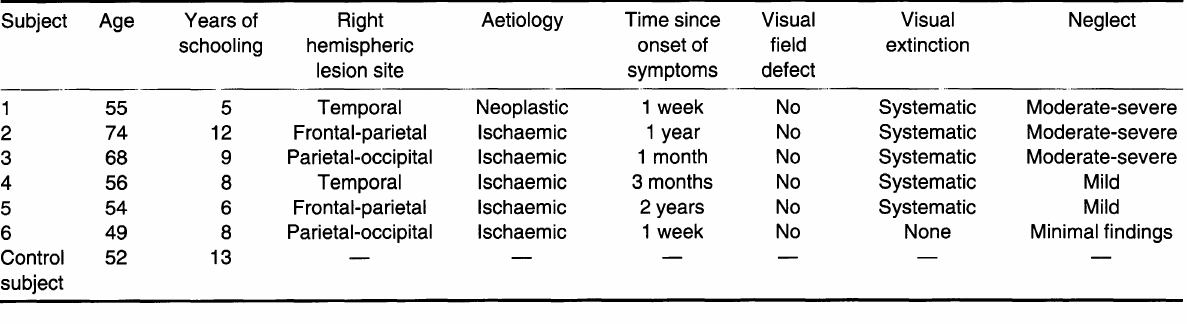
TABLE I. Main demographic and clinical characteristics of the